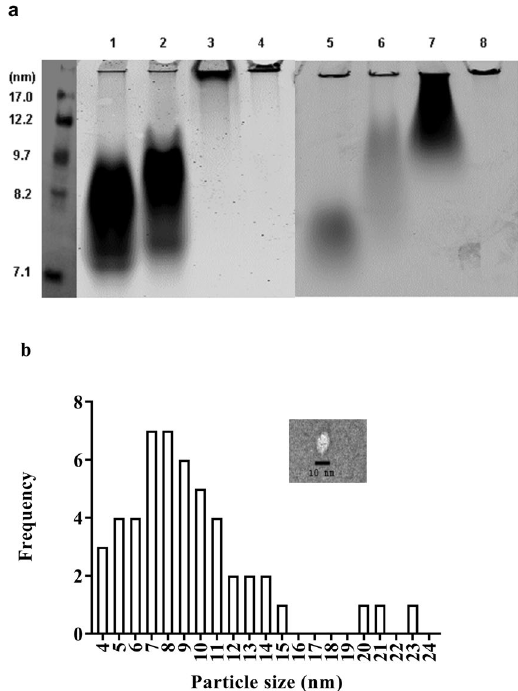
Figure 3. ELK-generated particle size by native gel electrophoresis and TEM. ( a ) Lipid particles generated by incubation of peptides with DMPC lipid vesicles (lanes 1 = neu, 2 = hyd, 3 = pos, 4 = neg) and a mixture of natural lipids found in cellular membranes (lanes 5 = neu, 6 = hyd, 7 = pos, 8 = neg). Both types of lipids were suspended in PBS at 1 mg/ml along with 0.5% PE-rhodamine. The vesicles were incubated with 0.5 mg/ ml peptides in PBS at room temperature for 2 hours with gentle shaking. The lipid particles formed by peptides were separated in a 1D native TBE gel and scanned using a Typhoon scanner. ( b ) Particle size distribution after reconstitution of neu with phospholipid and cholesterol (neu:POPC = 1:6.25 and cholesterol:POPC = 1:10). Mean size of particles is 9.2 nm. Inset shows a TEM image of a representative particle made with neu. Scale 10 nm, magnification 50000X. Uncropped images of Fig. 3 are provided in Supplementary Figures 2, 3 and